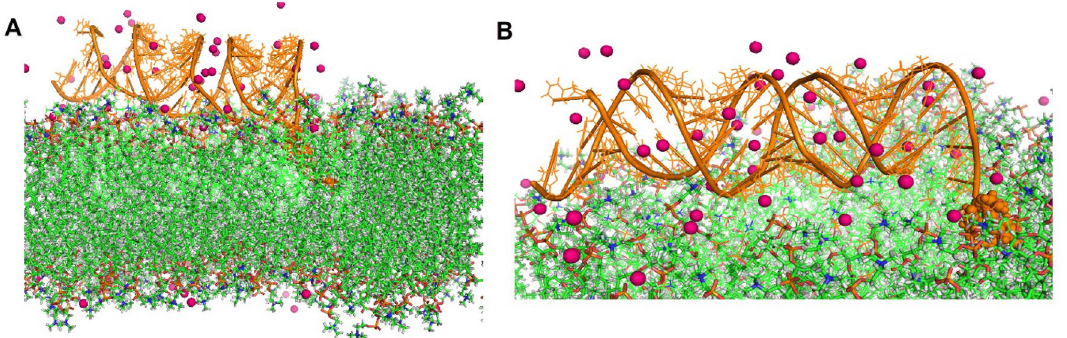
Figure 5. The presentation of the lipid bilayer and siRNA in the presence of Mg 2+ ions that surrounded it using VMD ( A ) and ( B ) pictures are related to the adsorption of siRNA molecules on the membrane, which is surrounded by Mg 2+ ions. Many Mg 2+ ions were located at minor and major grooves of siRNA which can affect the structure of